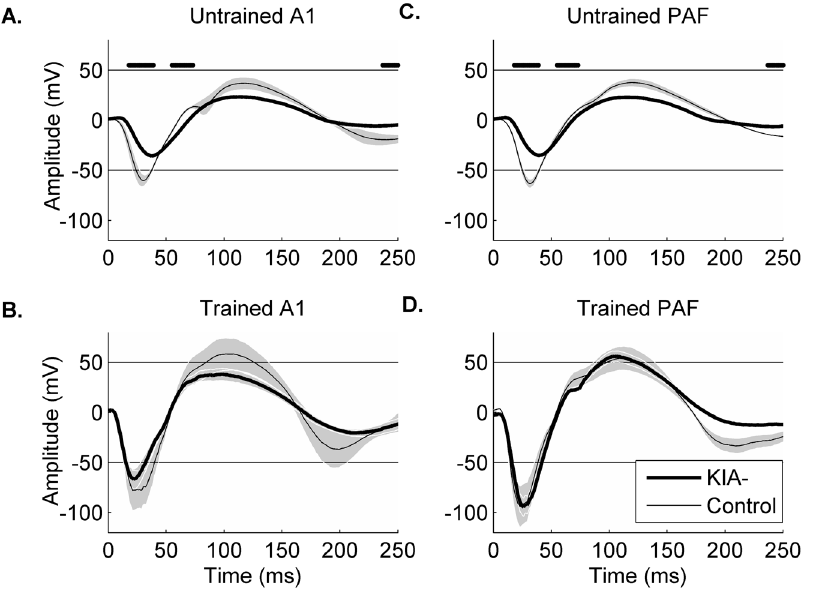
Figure 8. Extensive behavioral training shortens latency and increases amplitude of N1 component of LFP response. Responses are plotted with gray markers at 2 50 and 50 mV to help visualize differences across plots. Significant differences are marked by a black line. A . LFP response to the sound /dad/ in untrained control and KIA- A1. B . Extensive training improves onset latency and amplitude of the LFP response in KIA- A1. C . LFP response to the sound /dad/ in untrained control and KIA- PAF sites. As was seen in A1 recordings, latency and amplitude of KIA- PAF responses were significantly different from control recordings. D . Following training, there were not significant differences in the LFP response to the sound /dad/ between control PAF and KIA- PAF.